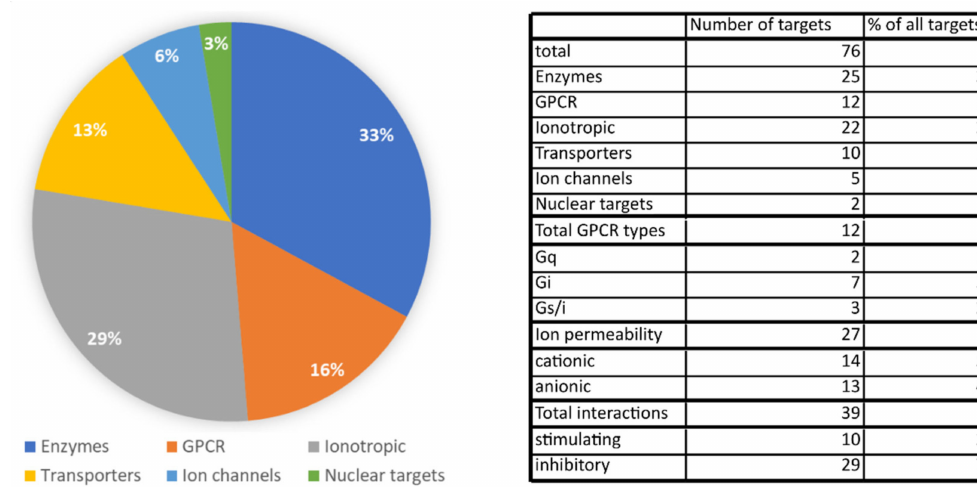
Figure 5. Pie chart showing the percentage of specific protein targets of CBD from a pool of all protein targets. Table presenting the number of identified CBD targets and percentage of specific G α proteins coupled to GPCR receptors and ion permeability of both ion channels and ionotropic receptors. The total number of final effects on cell membrane potential was calculated based on the type of G α proteins coupled to GPCR receptors targeted by CBD and ion permeability of those targets together with pharmacological action of CBD (for example, inhibition of anionic ion channel was counted as a stimulatory